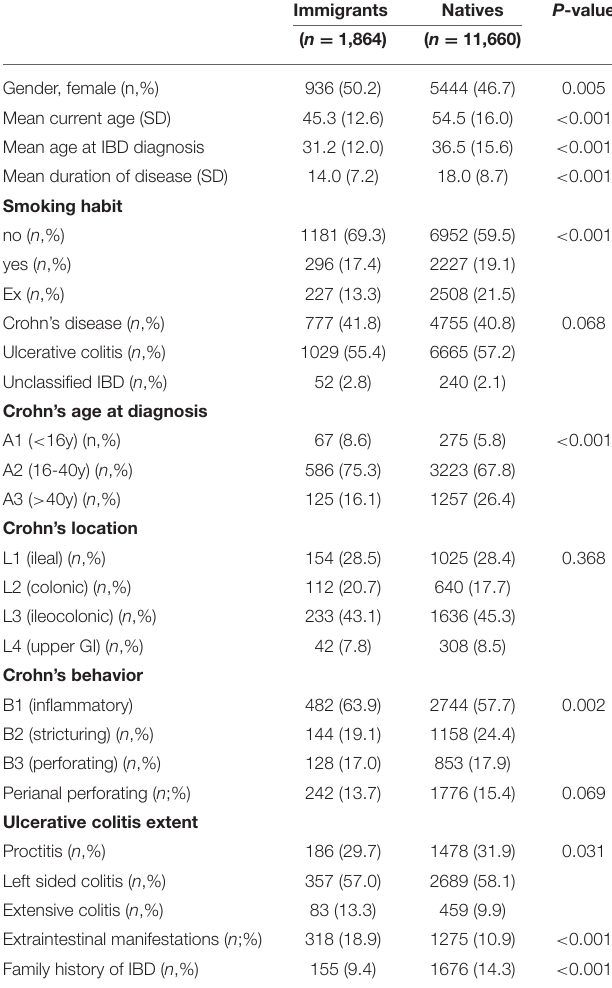
TABLE 1 | Demographic and clinical characteristics of the immigrant and native-born IBD population in Spain. Immigrants